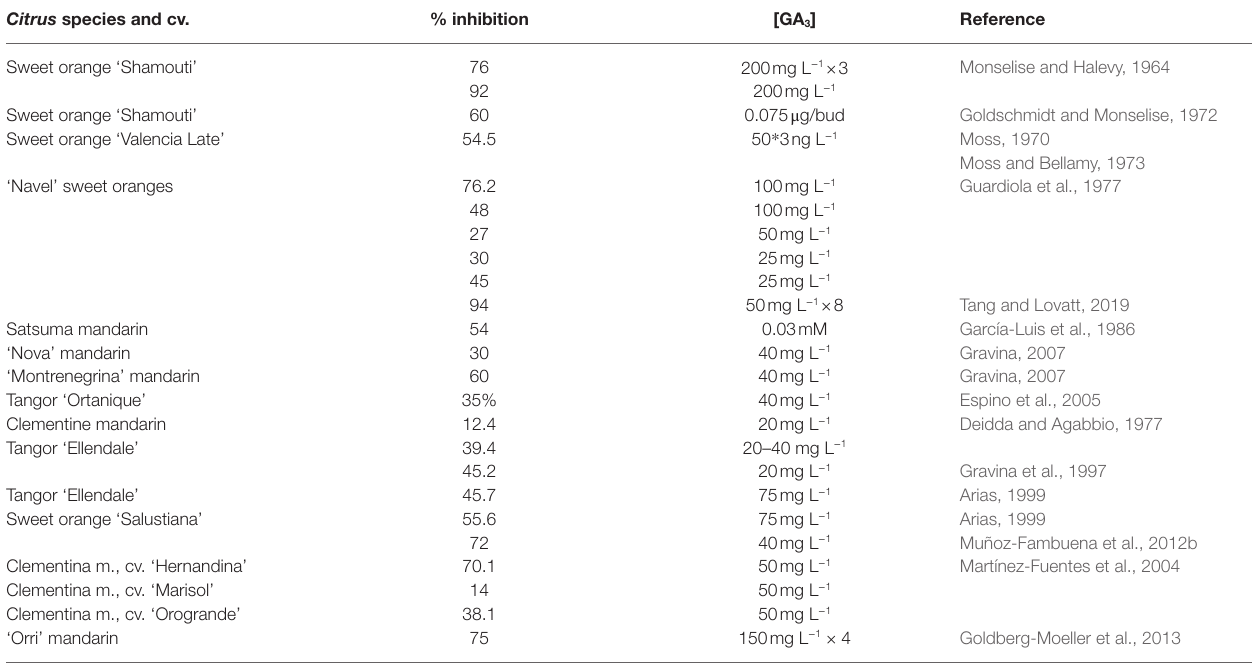
TABLE 1 | Current uses of gibberellic acid (GA 3 ) to reduce flowering in Citrus . Citrus species and